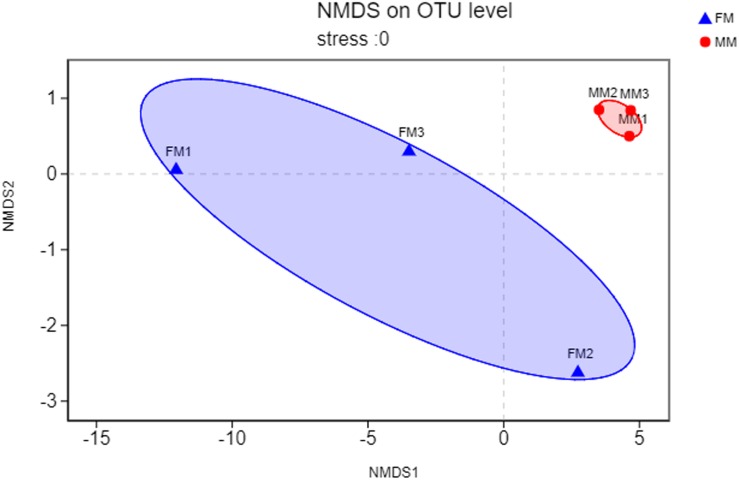
NMDS ordination based on Binary_euclidean similarities of bacterial communities. The blue triangles represent female swamp eels (FM), and the red circles represent male swamp eels (MM).